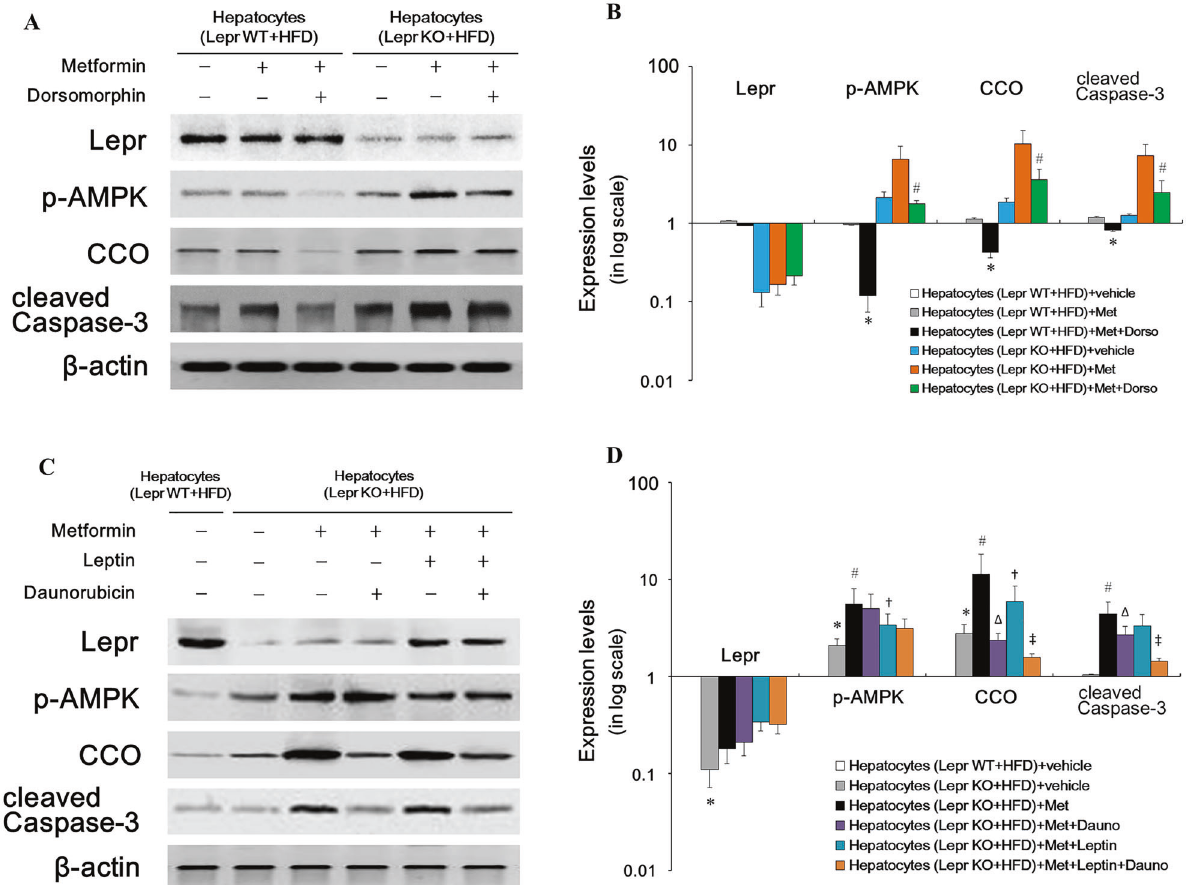
Fig. 5 The p-AMPK and CCO are downstream effectors of Lepr . Puri fi ed hepatocytes were cultured in the medium either with or without metformin (10 μ M), or AMPK inhibitor Dorsomorphin for 96 h, before they were harvested and subjected to Western blotting analysis. Meanwhile, in a subset of the experiment, hepatocytes were pre-treated with cytochrome C oxidase (CCO) inhibitor Daunorubicin for 24 h, before switching to medium supplemented with metformin (10 μ M) and leptin (10 μ M; Sigma) for 72 h. After that, hepatocytes were harvested and subjected to Western blotting analysis. A Western blotting images of hepatocytes, with and without metformin/or dorsomorphin. B Quantitative analysis of A . Except for p-AMPK ( n = 10), n = 12. Band intensities in A were quanti fi ed in Image Lab (Bio-Rad), and the protein expression level was normalized to the β -actin level. Data are presented on a logarithmic scale as the fold change in expression relative to the hepatocytes derived from HFD-fed Lepr WT rats in the absence of metformin and dorsomorphin. * p < 0.05 vs. hepatocytes derived from HFD- fed Lepr WT rats in the absence of metformin or dorsomorphin; # p < 0.05 vs. hepatocytes derived from HFD-fed Lepr-KO rats in the absence of dorsomorphin. C Western blotting images of hepatocytes, with and without metformin, leptin or daunorubicin. D Quantitative analysis of C . Except p-AMPK ( n = 10), n = 12. Band intensities in C were quanti fi ed in Image Lab (Bio-Rad), and the protein expression level was normalized to the β -actin level. Data are presented on a logarithmic scale as the fold change in expression relative to hepatocytes derived from HFD-fed Lepr WT rats in the absence of metformin, leptin or daunorubicin. * p < 0.05 vs. hepatocytes derived from HFD-fed Lepr WT rats in the absence of metformin, leptin or daunorubicin; # p < 0.05 vs. hepatocytes derived from HFD-fed Lepr-KO rats in the absence of metformin, leptin or daunorubicin; Δ p < 0.05 vs. hepatocytes derived from HFD-fed Lepr-KO rats in the absence of leptin or daunorubicin; † p < 0.05 vs. hepatocytes derived from HFD-fed Lepr-KO rats in the absence of leptin; ‡ p < 0.05 vs. hepatocytes derived from HFD-fed Lepr-KO rats in the absence of